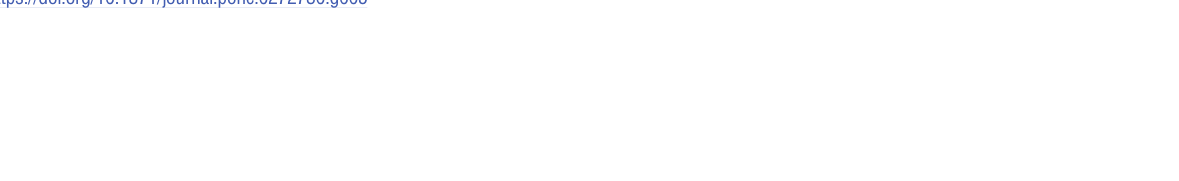
PLOS ONE | https://doi.org/10.1371/journal.pone.0272730 August 9, 2022 10 /